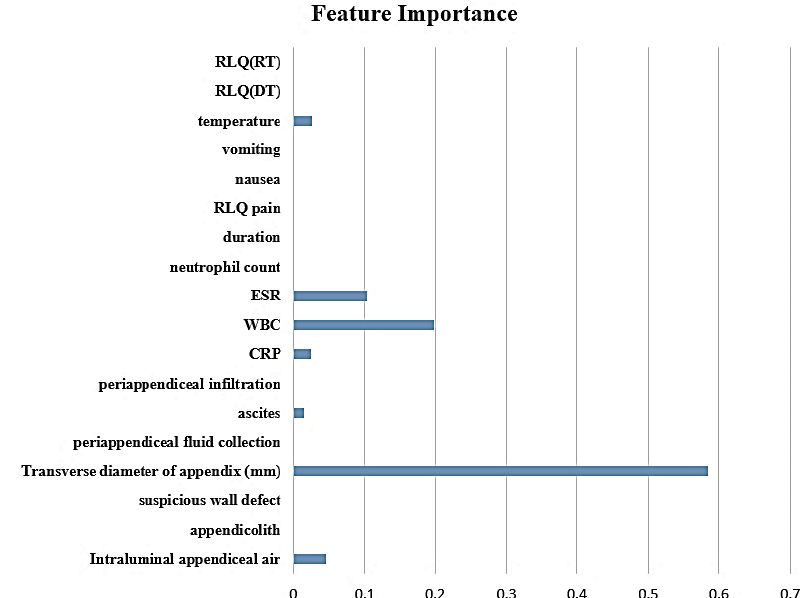
Figure 1. Ranking of feature importance.